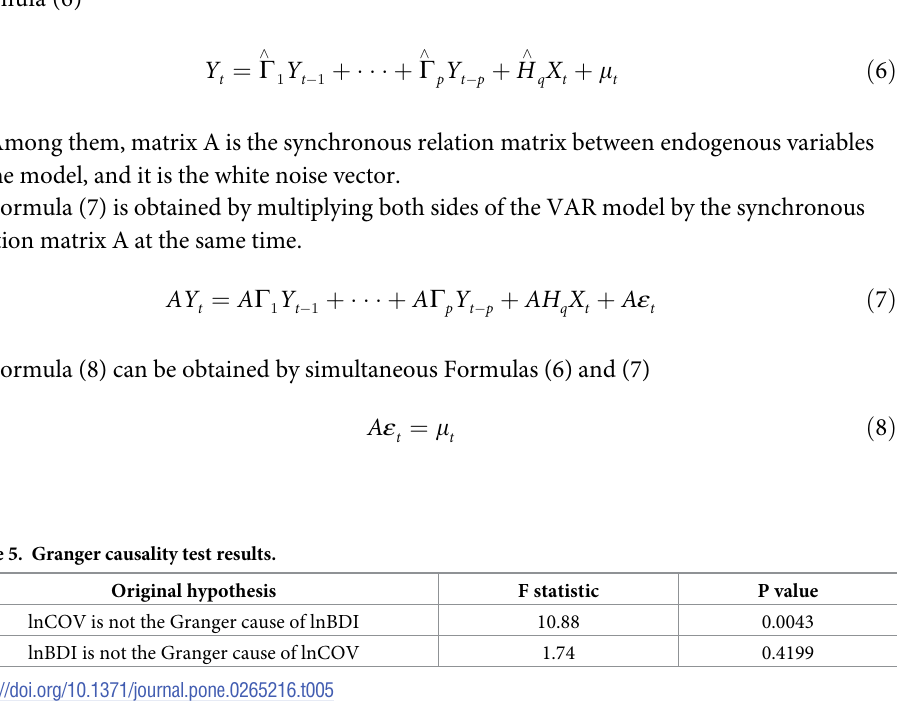
pandemic was mainly affected by the policies of various countries and regions in the sample period and was closely related to passenger transport. The development of a dry bulk shipping market dominated by cargo transport is not significant. Under the background of global sup- ply chain development, the dry bulk shipping market is strongly correlated with the develop- ment of public health emergencies. real-time structural relationship among system variables is hidden in the random distur- bance term, and the explanation of this part is ignored. The SVAR model adds synchro- nous variables to the VAR model, which can directly reflect the real-time structural relationship among variables [26]. The BDI index and other variables reflecting market price changes will quickly absorb the impact of current related variables and give feedback on the changes of current related variables. Considering the characteristics of this kind of data, the analysis depth of the VAR model established only by considering the lag effect of endogenous variables is insufficient. The basic expression of the SVAR model is shown in Formula (6)